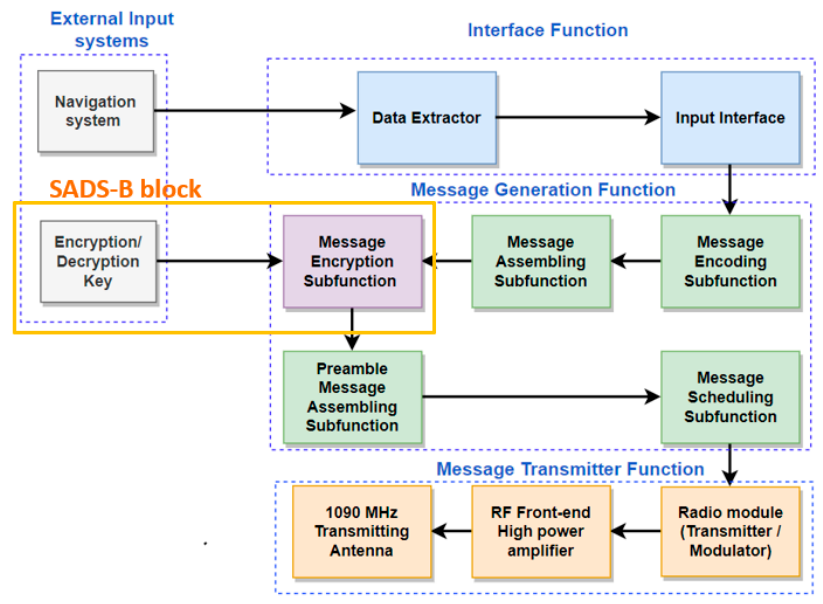
Figure 3. SADS-B Out subfunction block diagram.